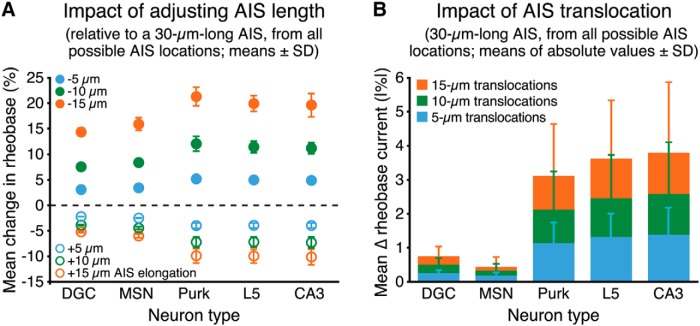
Impact of AIS plasticity on the excitability of morphologically realistic neurons. A, Plots of the mean changes in rheobase currents (percentage ±SD) observed after elongating or shortening the AIS by 5, 10, or 15 µm (relative to a 30-µm-long baseline AIS), across all possible AIS locations within 100 µm of the soma, in reconstructed neuron morphologies having simulated dendritic spines (see Materials and Methods) and uniform sodium and potassium conductance densities in the AIS (AIS Model D). B, Plots of the mean absolute values of changes in rheobase (percentage ±SD) observed after translocating the AIS by 5, 10, or 15 µm across all possible AIS positions within 100 µm of the soma. Note the different y-axis scales in A and B.